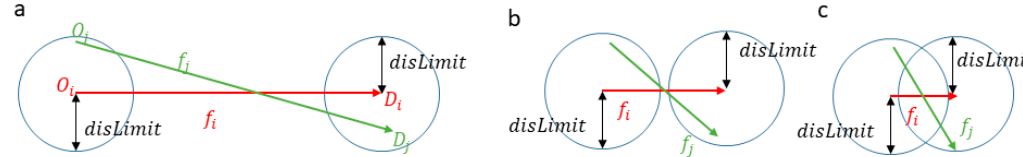
Figure 2. Similarity relationships with same disLimit values and di ff erent OD flow lengths: ( a ) Flows with long lengths; ( b ) Flows with middle lengths; ( c ) Flows with short lengths.